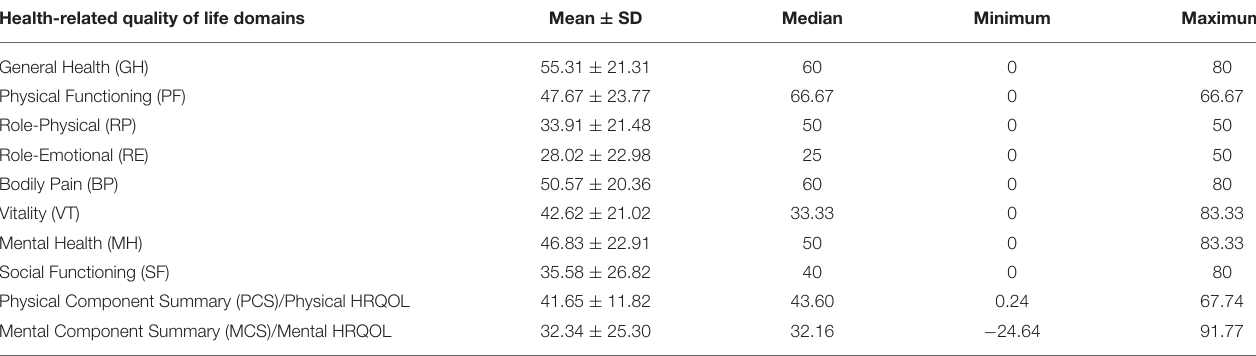
TABLE 3 | Health-related quality of life status of the participants during COVID-19 lockdown ( N = 878). Health-related quality of life domains